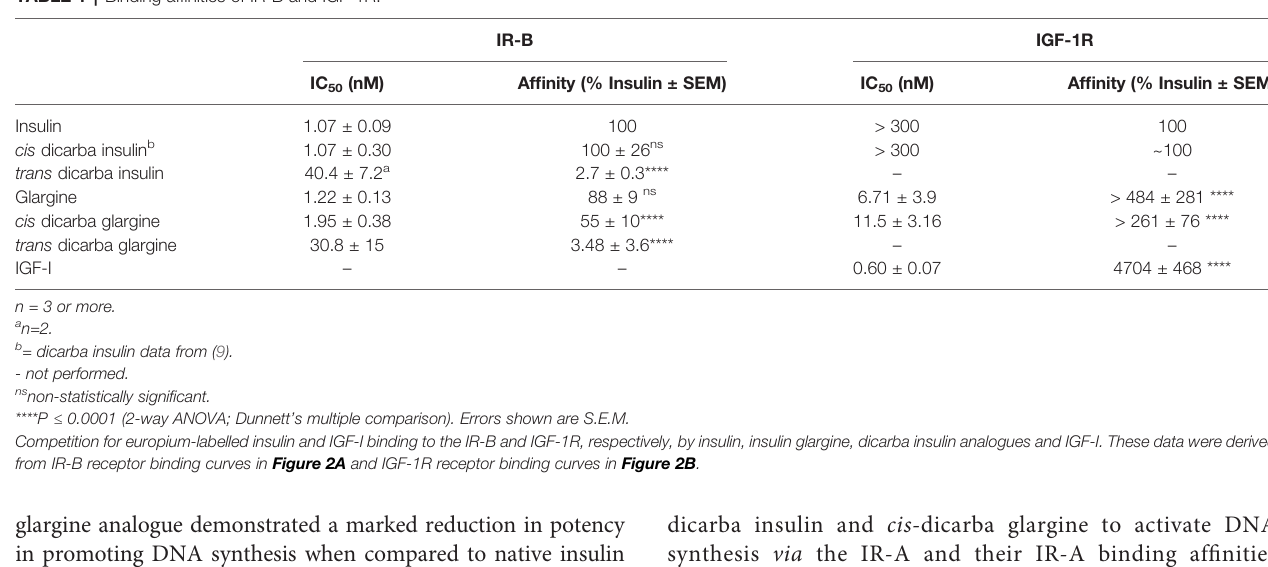
[ Figure 3B ; Figure S2 (9)]. The introduction of the A6-A11 dicarba bond signi fi cantly reduced mitogenic activity by ~8-10